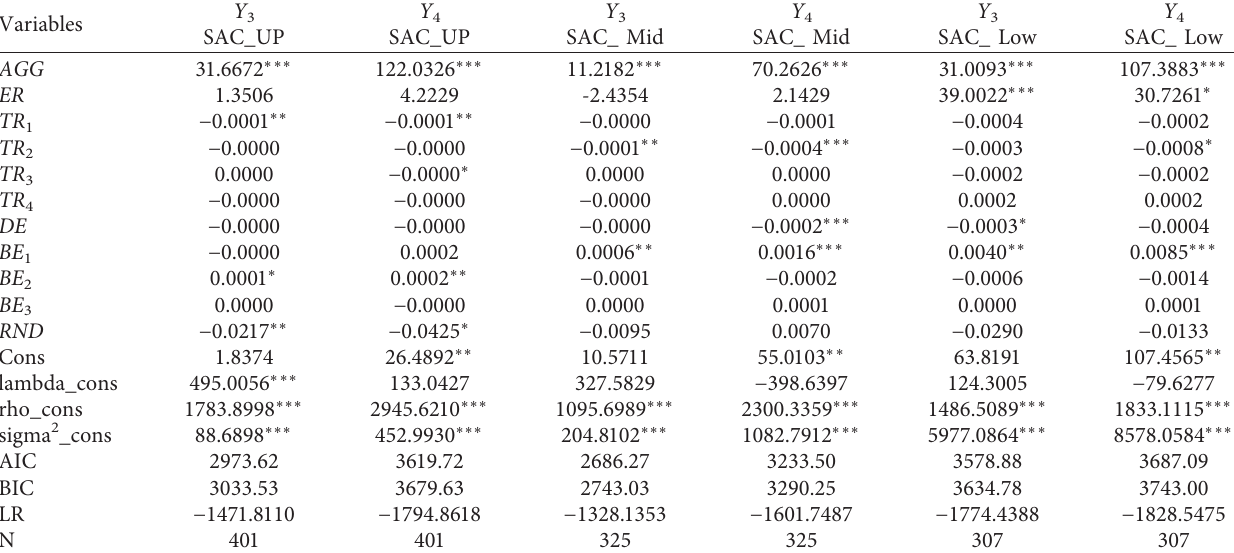
Table 6: SAR model results for typical regions,